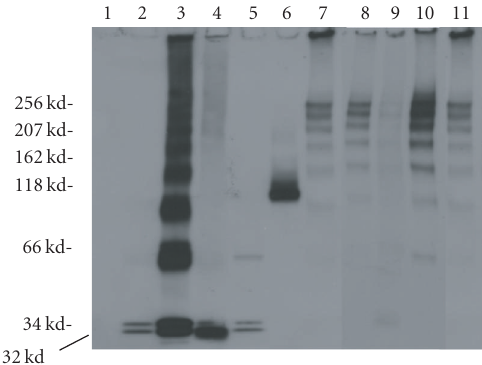
Figure 8: Oligomers formed by PVL and modified toxins. Oligomers were checked in solution or after recovery from treated human PMNs, 3–8% (w/v) SDS-PAGE and immunoblotting with anti-LukS-PV and anti-LukF-PV a ffi nity-purified rabbit antibod- ies. Lane 1: PMNs only, lane 2: LukS-PV + LukF-PV in solu- tion (4ng each), lane 3: LukS-PV + LukF-PV (4ng each/load) treated by 0.3 mM glutaraldehyde, lane 4: LukS-PV + LukF-PV saponin/treated with 3mM glutaraldehyde. Lanes 5–11: each PVL components (30ng each/load) was applied on PMNs, lane 5: LukS- PV + LukF-PV saponin treated, lane 6: LukS-PV + LukF-PV saponin- and glutaraldehyde treated without heating at 100 ◦ C, lane 7: LukS-PV + LukF-PV saponin at 0 ◦ C/glutaraldehyde treated and boiling at 100 ◦ C, lanes 8–11: toxins applied on PMNs, saponin treatment at room temperature + 1mM glutaraldehyde and boiling, lane 8: LukS-PV + LukF-PV, lane 9: LukS-PV-1C-R16C + LukF-PV S8C-K20C, lane 10: LukS-PV N2C-R16C + LukF-PV S8C-K20C, lane 11: LukS-PV + LukF-PV